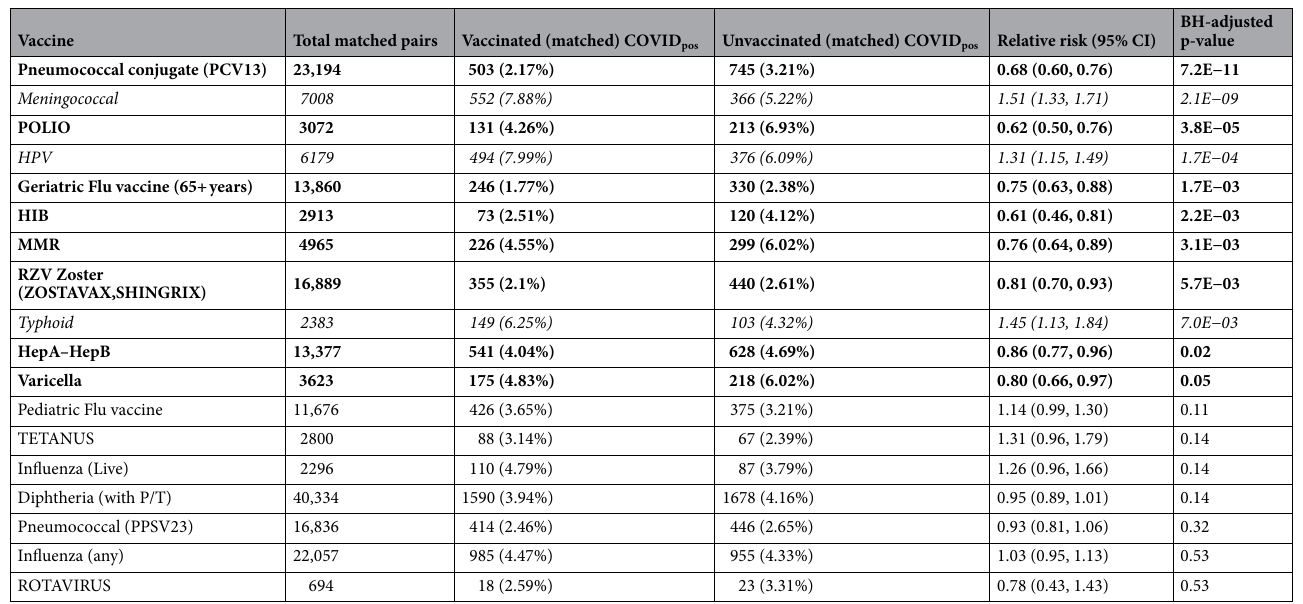
Table 6. Summary of SARS-CoV-2 rates for vaccinated and unvaccinated propensity score matched cohorts (5 year time horizon). Table of SARS-CoV-2 infection rates for vaccinated and unvaccinated (matched) cohorts for vaccines administered within 5 years prior to PCR testing. Rows in which the SARS-CoV-2 rate is lower (adjusted p-value < 0.05) in the vaccinated cohort are highlighted in bold and rows in which the SARS-CoV-2 rate is lower in the unvaccinated cohort are highlighted in italics. The columns are (1) Vaccine: Name of the vaccine, (2) Total matched pairs: Number of pairs from the propensity matching procedure, which is the sample size of both vaccinated and unvaccinated cohorts after matching, (3) Vaccinated (matched) COVID pos : Number of COVID pos cases among the vaccinated (matched) cohort, along with the percentage in parentheses, (4) Unvaccinated (matched) COVID pos : Number of COVID pos cases among the unvaccinated (matched) cohort, along with the percentage in parentheses, (5) Relative risk (95% CI): Relative risk of COVID pos in the vaccinated (matched) cohort compared to the unvaccinated (matched) cohort, along with 95% confidence interval in parentheses, (6) BH-adjusted p-value: Benjamini–Hochberg-adjusted Fisher exact test